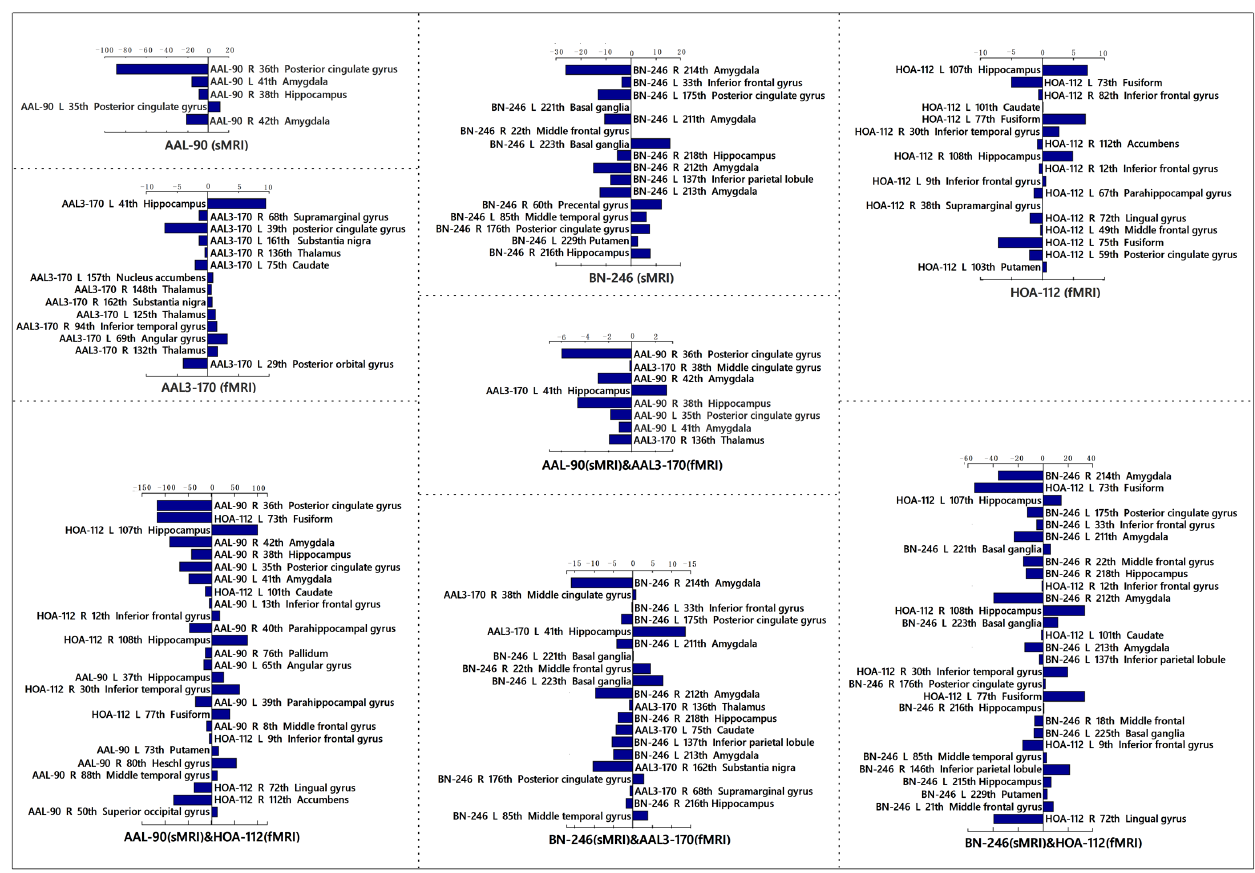
Figure 5. The weighted contributions of these most discriminative features in single-modal or multi- modal